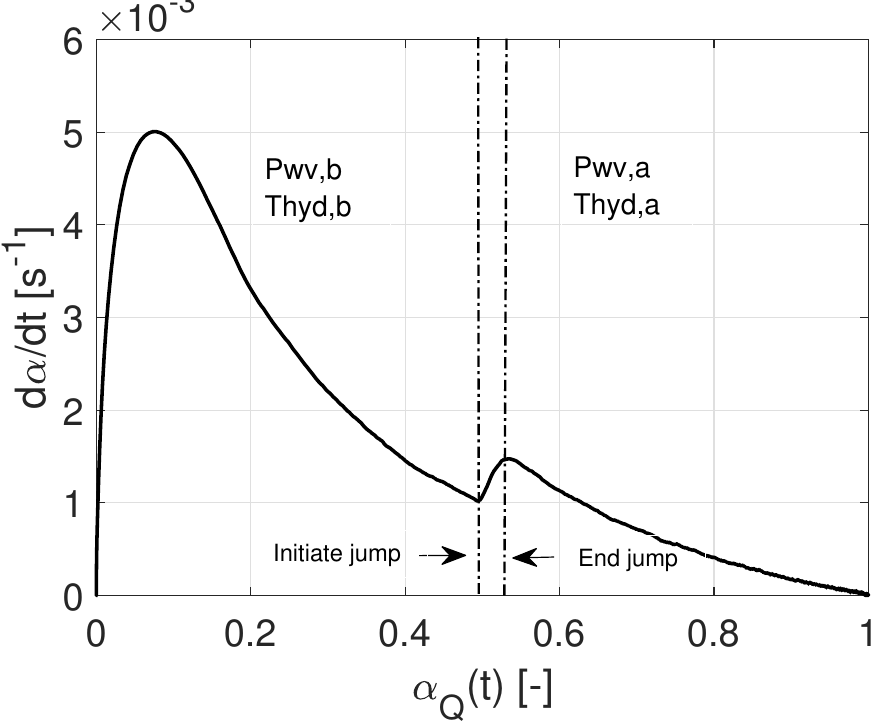
Figure 8. α Q versus the hydration conversion rate for a single jump experiment. P wv , b = 10